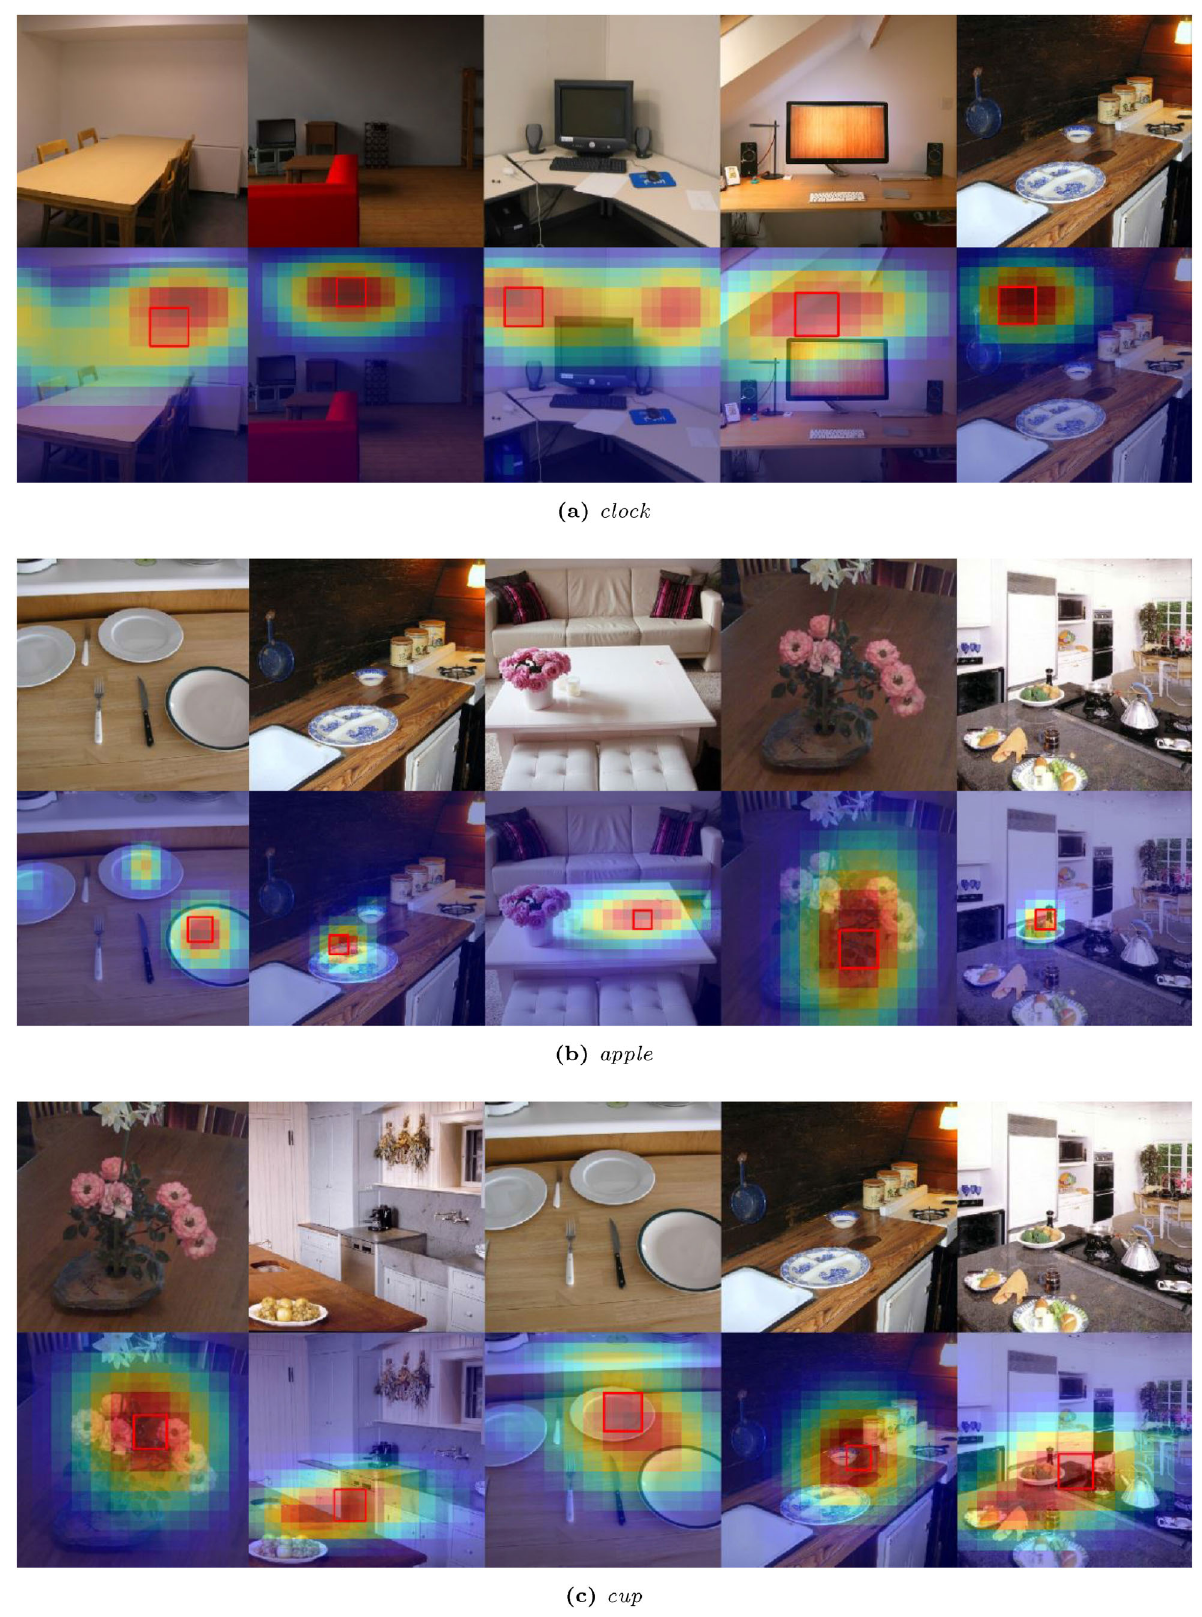
Fig. 3 Scene retrieval results, showing the top 5 retrieved scenes for clock, apple, cup . Each category shows, above: the original images, and below: the scenes overlaid with automatically generated bounding boxes and